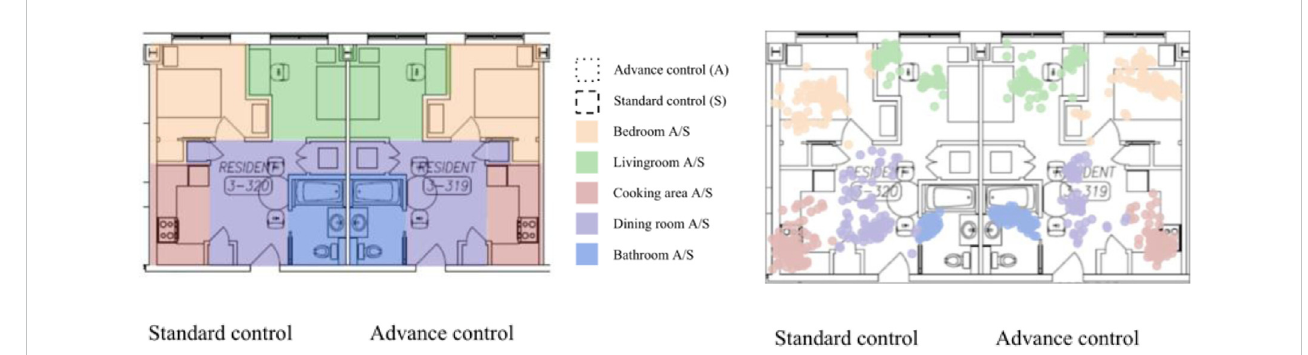
FIGURE 5 (A) RTLS zone con fi guration assignment for the main study; (B) and RTLS temporal readings: green dots – living room, purple dots – dining room, red dots – cooking area, blue dots – bathroom, orange dots –